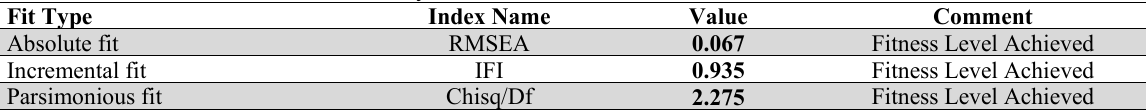
Achieved Fitness Indexes of the